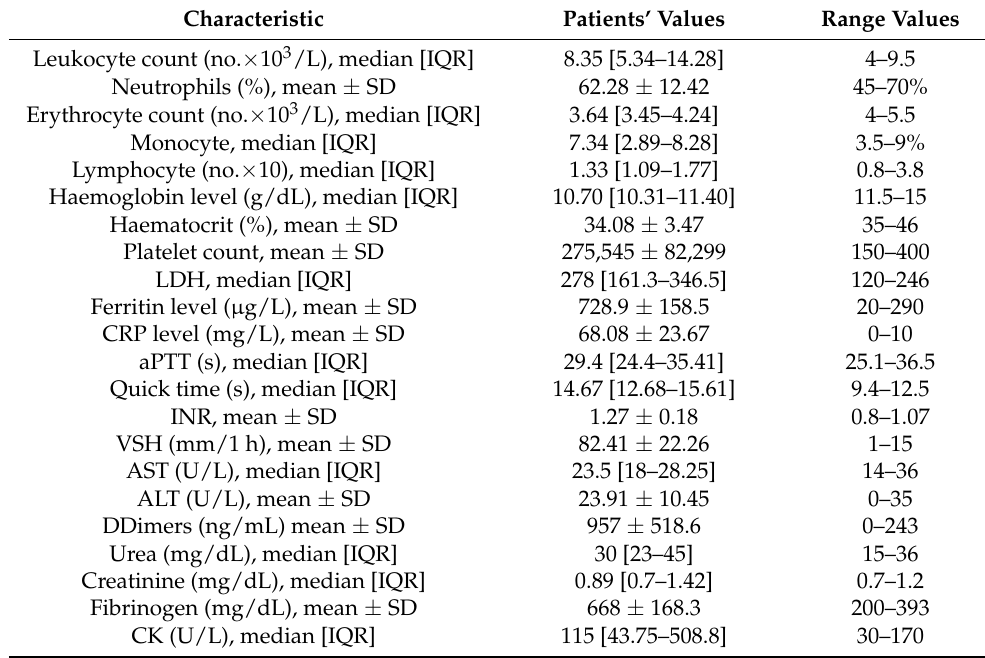
Table 2. Preoperative laboratory findings in our